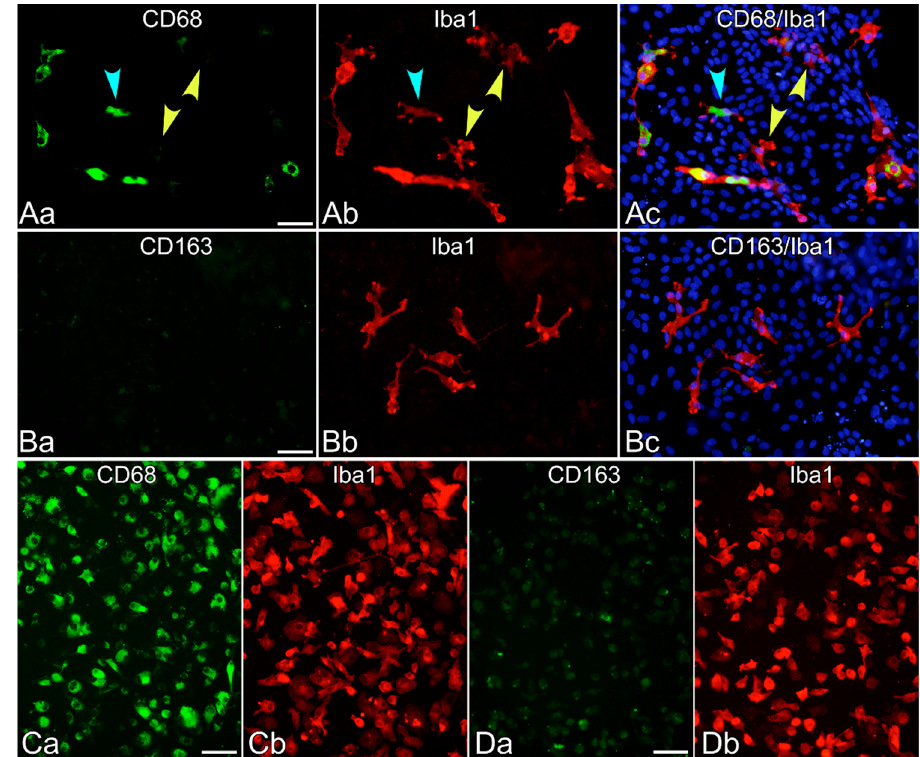
Figure 6. Expression of CD68 and CD163 in Iba1 + cells derived from dissociated leptomeningeal aggregates in the dissociated culture ( A , B ) or from the mixed glial culture ( C , D ). ( A ) Both CD68 + (green, denoted by blue arrowheads) and CD68 − or weak (green, denoted by yellow arrowheads) cells were observed among Iba1 + cells (red) derived from the leptomeningeal culture. Nuclei were stained blue by Hoechst 33258. ( B ) No significant expression of CD163 (green) was observed in any of the leptomeninges-derived Iba1 + cells (red). Nuclei were stained blue by Hoechst 33258. ( C ) Almost all primary microglia (Iba1, red) isolated from the mixed glial culture strongly expressed CD68 (green). ( D ) Significant punctate immunostaining of CD163 (green) was observed in many of the primary microglia (Iba1, red). Cells shown here were fixed after they were cultured in FCS-DMEM on PLL-coated glass coverslips for 2 days. Scale bar = 50 µ m.